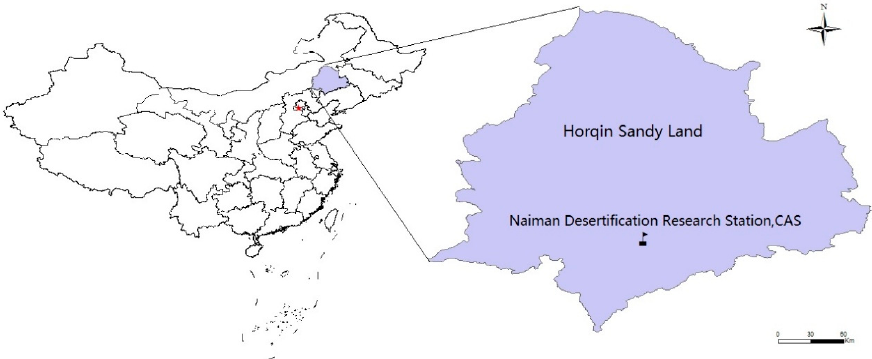
Figure 1. Location of Naiman desertification research station in China.